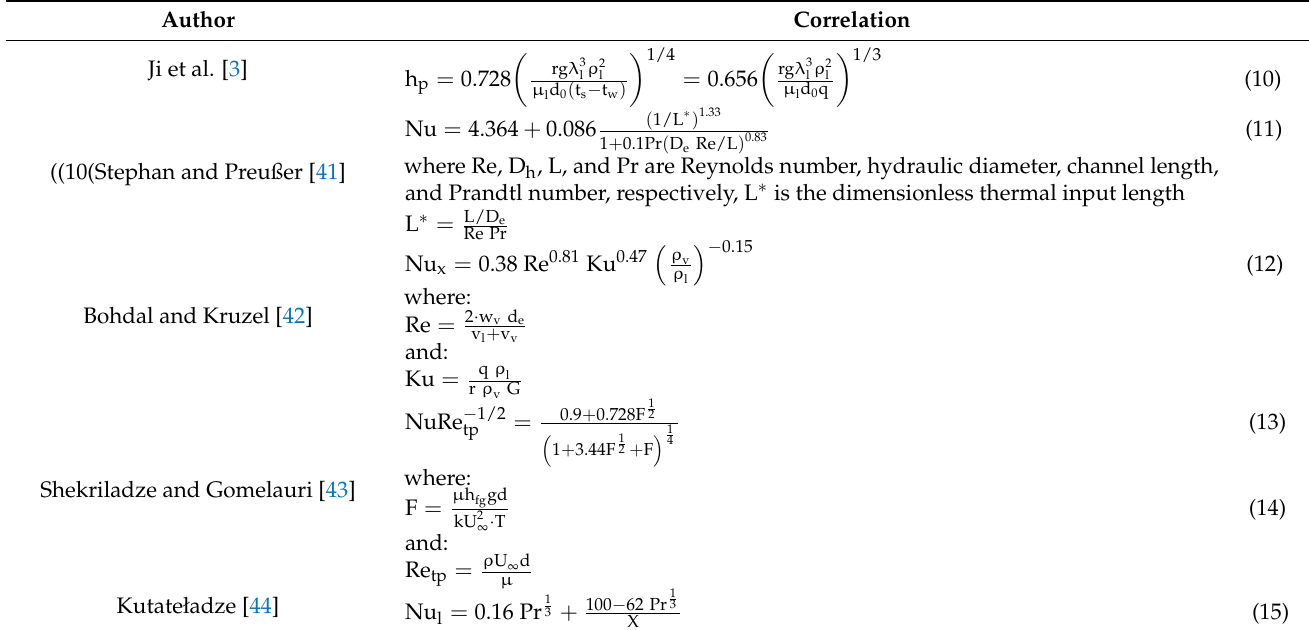
Table 3. Correlations used to compare the results of own experimental research for heat transfer during refrigerants’ external